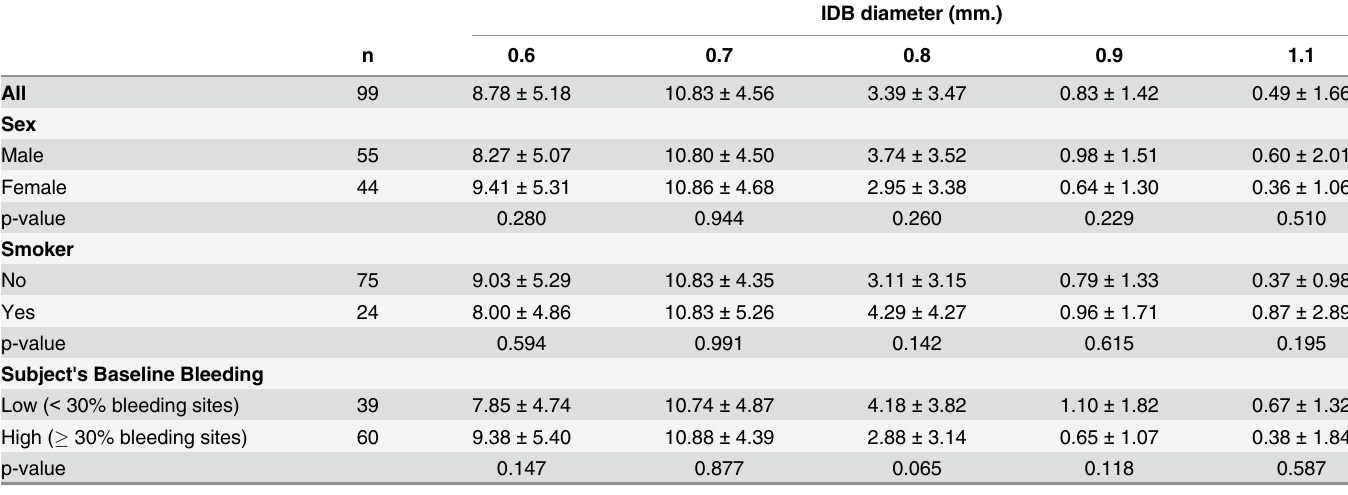
Table 2. Distribution (mean ± sd) of the number of interproximal sites according to the diameter of the interproximal brush in 99 adults.